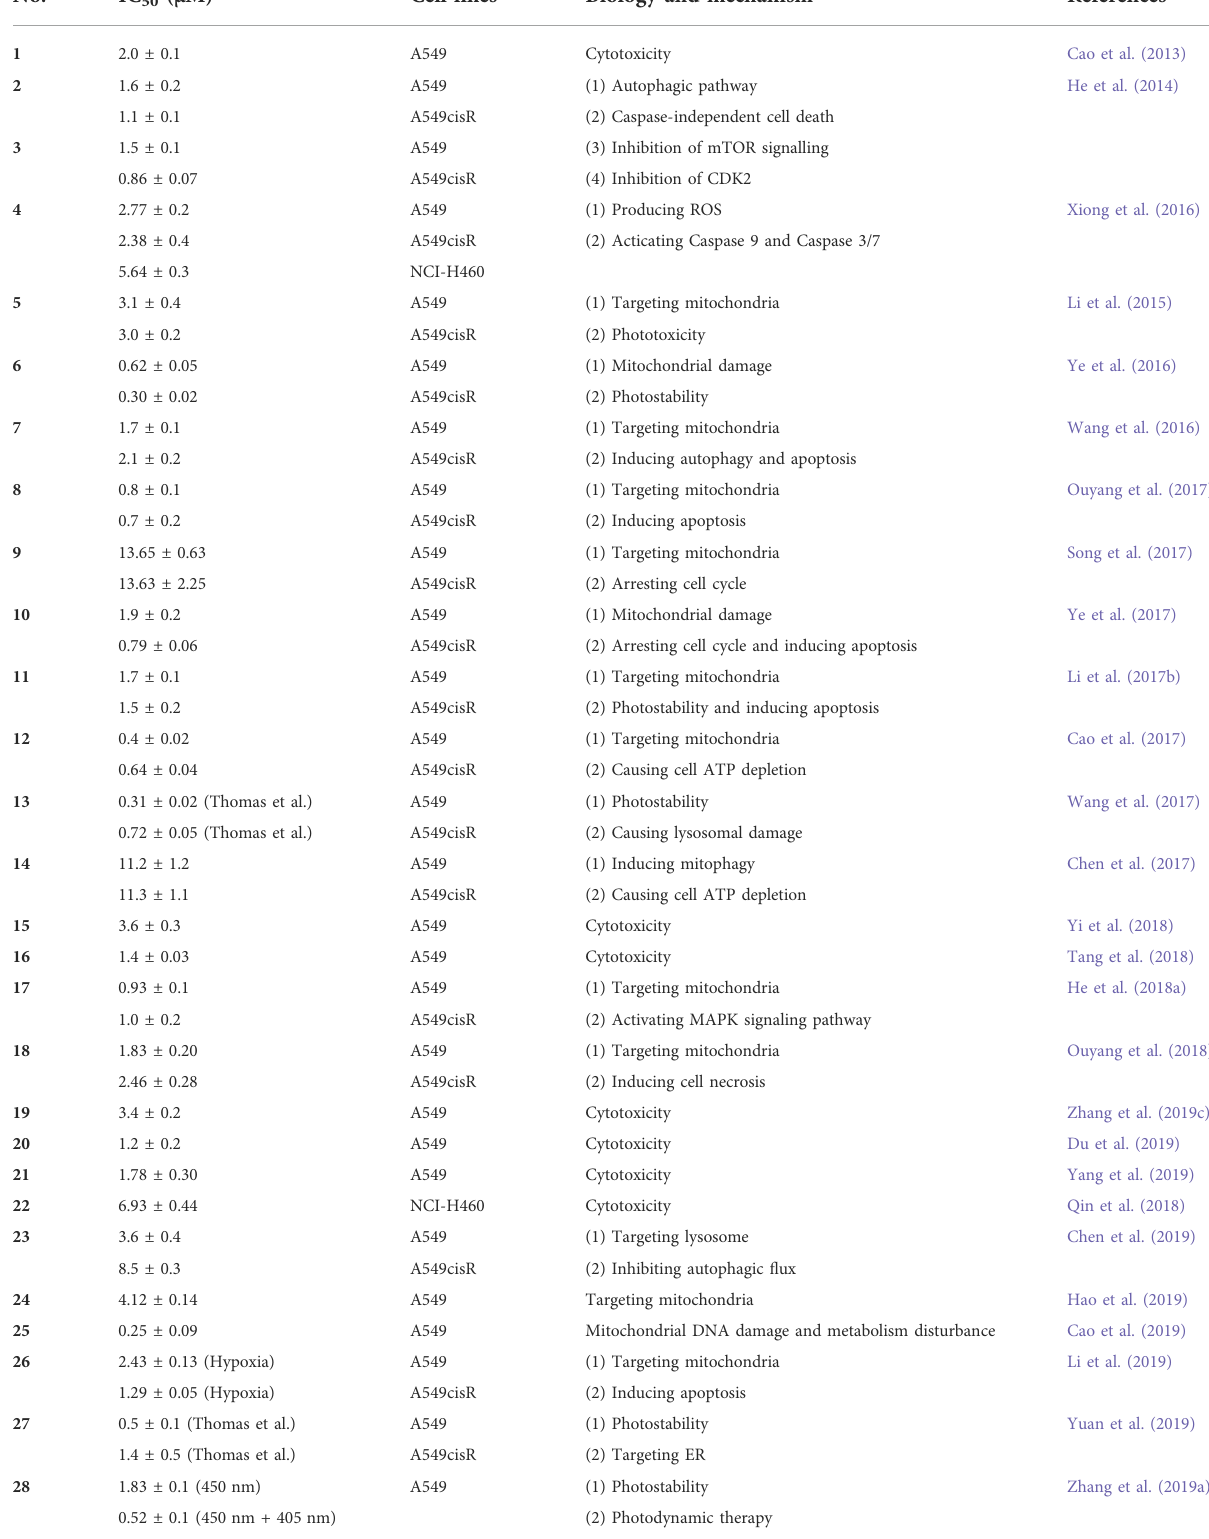
TABLE 1 Cyclometalated Iridium (III) compounds as promising candidates against lung